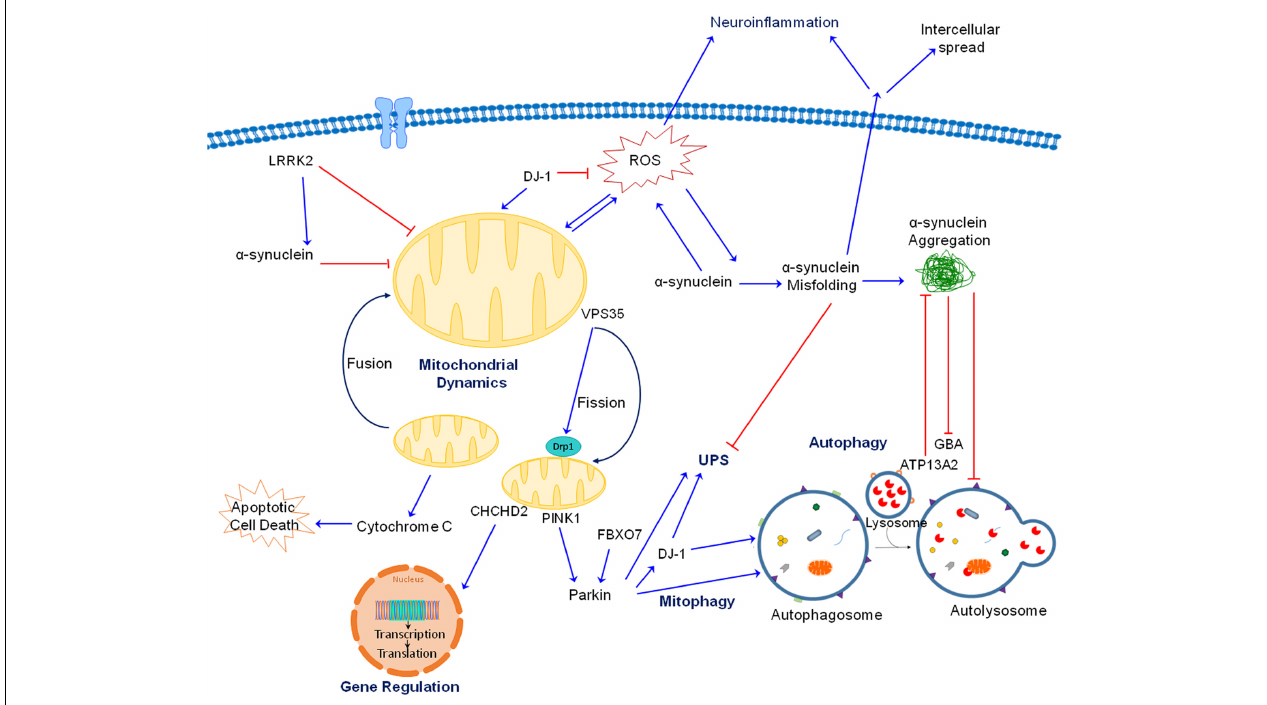
FIGURE 2 | Interactions between gene products linked to PD. As discussed in the text, both genetic mutations and neurotoxicants linked to PD impair mitochondrial function, whether directly or indirectly by interacting with each other. For the autosomal recessive gene products, PINK1 is accumulated at outer mitochondrial membrane (OMM) of damaged mitochondria, where it recruits Parkin which ubiquitinates proteins and target them for degradation. Together, PINK1 and Parkin play an important role in maintaining mitochondrial quality through mitophagy. As an antioxidant protein, DJ-1 is translocated to dysfunctional mitochondria when ROS is generated. DJ-1 also aids PINK1 and Parkin in removing damaged mitochondria. Additionally, FBX07 is involved in the recruitment of Parkin to damaged mitochondria and subsequent mitophagy. ATP13A2 is localized in lysosomes and is important for protein degradation. For the autosomal dominant gene products, accumulation of misfolded and aggregated α -synuclein can be induced by a variety of neurotoxicants and genetic mutations. Toxic α -synuclein can impair mitochondrial function, generate ROS and block autophagy/lysosomal function. Mutation in LRRK2 results in gain of toxic kinase function which impairs mitochondrial and autophagic function as well as promotes α -synuclein aggregation. VPS35 mutations increase binding to Drp1 resulting in mitochondrial fragmentation. Of note, mitochondrial fragmentation is a common observation induced by genes and toxicants linked to PD. CHCHD2 is rather unique because it is both a mitochondrial protein and transcription factor. Its mutation impairs complex IV function and expression of a complex IV subunit. Mutations in GBA, a lysosomal protein, impairs protein degradation and mitochondrial function. Although not shown for simplicity, neurotoxicants such as Mn also interact with these proteins (such as α -synuclein) to induce neurotoxicity. Together, there are extensive interactions between these proteins and neurotoxicants leading to